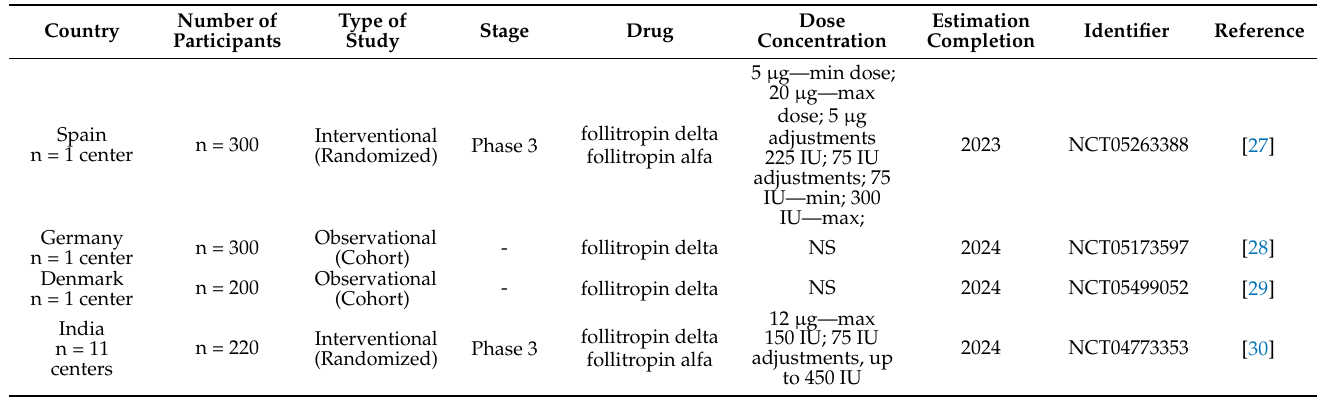
Table 2. Undergoing multinational and national projects with their